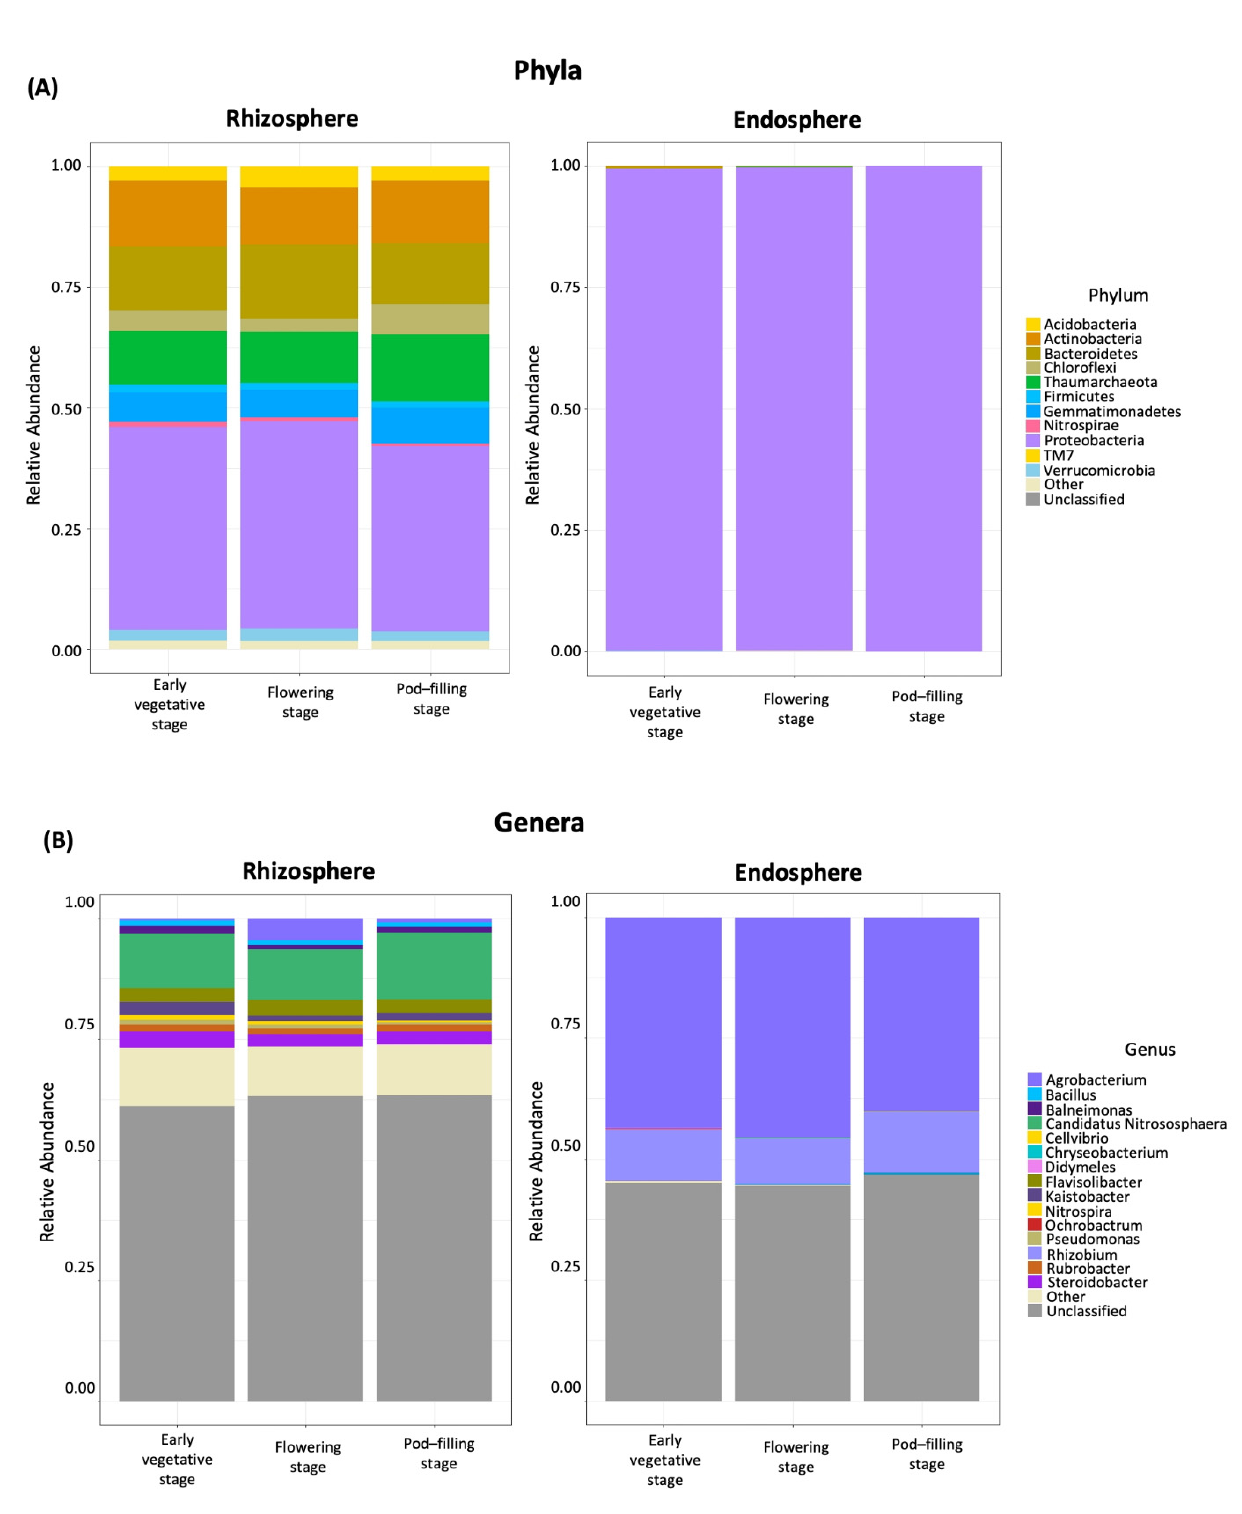
Figure 3. Dominating bacterial (and archaeal) taxa in the root microbiome of common bean ( P. vulgaris ) at three ontogenetic stages. The relative abundance of the ten most abundant taxa classified at the level of phylum ( A ) and genus ( B ) among all operational taxonomic units (OTUs) is presented for rhizosphere ( left ) and endosphere ( right ) samples separately for the vegetative, flowering and pod filling stage. Each bar plot represents data of n = 2 biologically independent samples for the vegetative and the flowering stage and n = 1 for the pod-filling stage and each colour indicates a different phylum or genus.